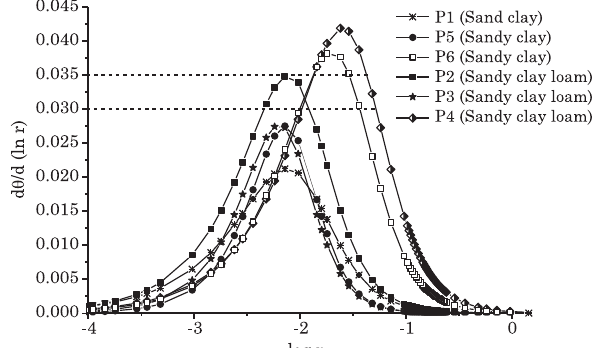
Figure 4. Pore size distribution determined by the derivative equation of the soil water retention curve (Equation 2) in function to the logarithm of the pore radius of hard-setting soils with sandy clay and sandy clay loam textures.